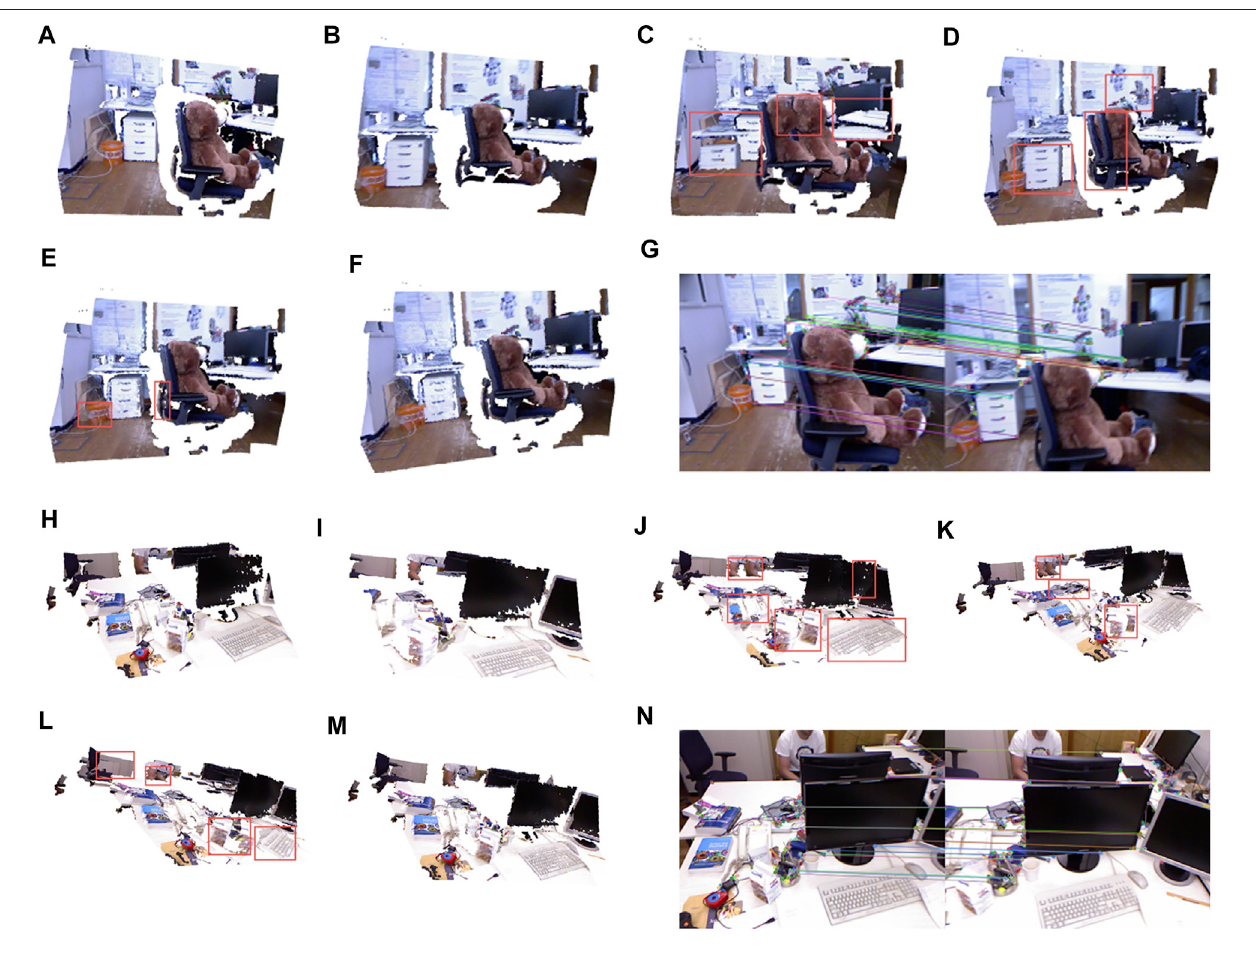
FIGURE 5 | Registration results of rgbd_dataset_freiburg1_teddy and rgbd_dataset_freiburg1_xyz. (A) Source point cloud of rgbd_dataset_freiburg1_teddy. (B) Target point cloud of rgbd_dataset_freiburg1_teddy. (C) Result of the ICP algorithm of rgbd_dataset_freiburg1_teddy. (D) Result of the NICP algorithm of rgbd_dataset_freiburg1_teddy. (E) Result of the Color 3D ICP of rgbd_dataset_freiburg1_teddy. (F) Result of our algorithm. (G) Orb matching result of rgbd_dataset_freiburg1_teddy. (H) Source point cloud of rgbd_dataset_freiburg1_xyz. (I) Target point cloud. (J) Result of the ICP algorithm of rgbd_dataset_freiburg1_xyz. (K) Result of the NICP algorithm of rgbd_dataset_freiburg1_xyz. (L) Result of the Color 3D ICP of rgbd_dataset_freiburg1_xyz. (M) Result of our algorithm of rgbd_dataset_freiburg1_xyz. (N) Orb matching result of rgbd_dataset_freiburg1_xyz.